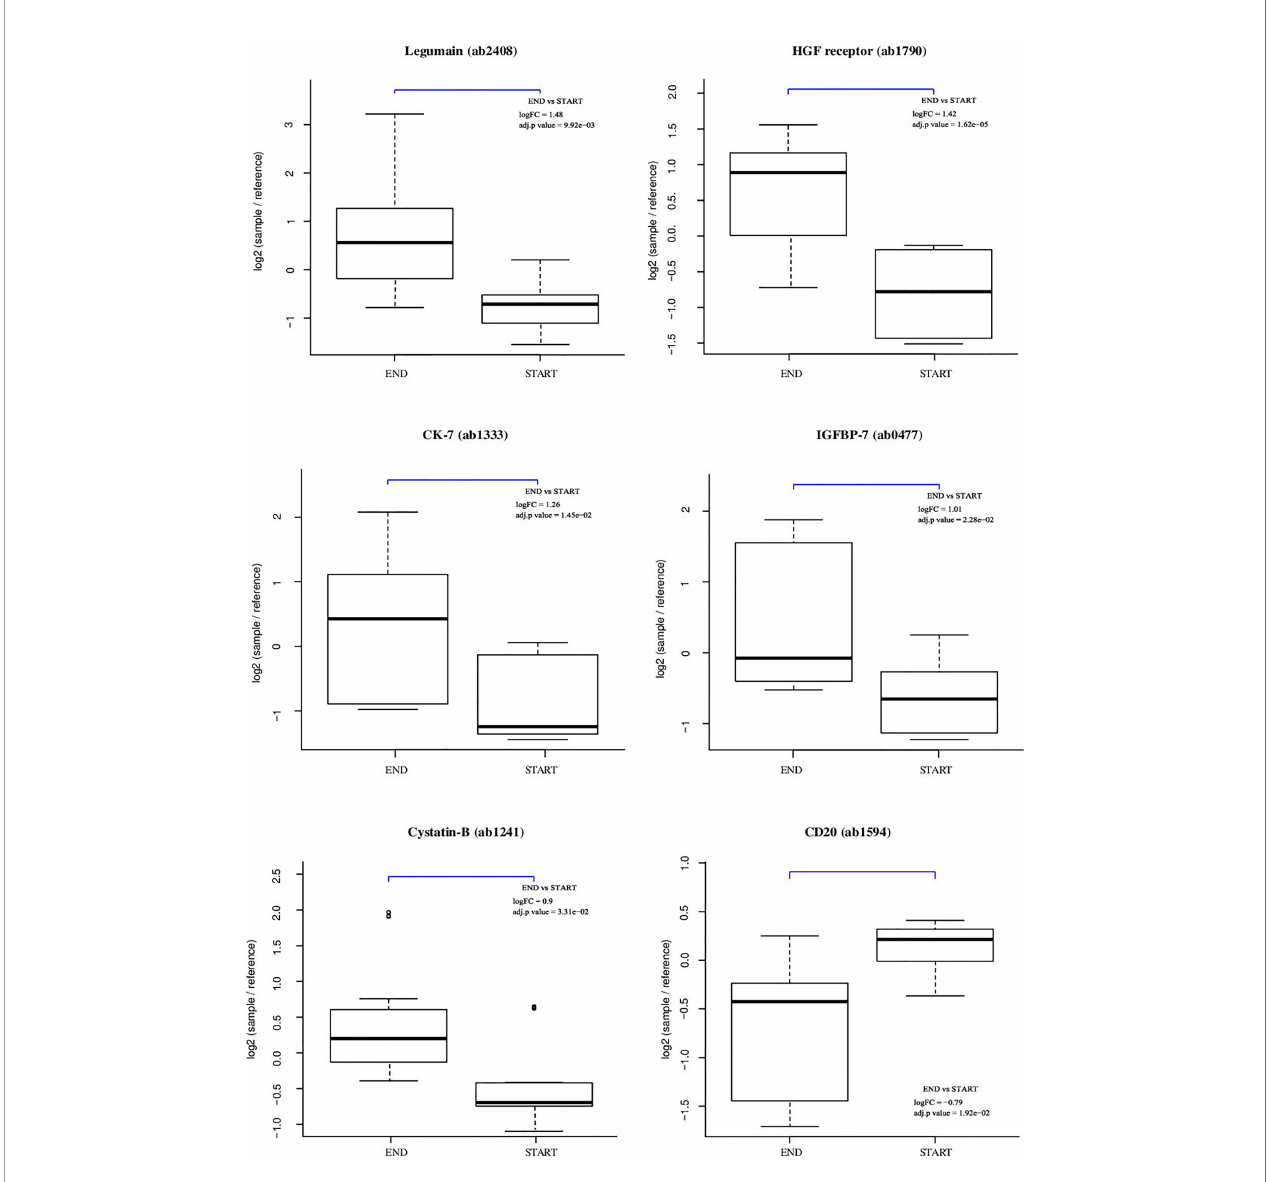
FIGURE 3 | Individual array values for a set of differential proteins. Each sample is measured by four replicate spots per